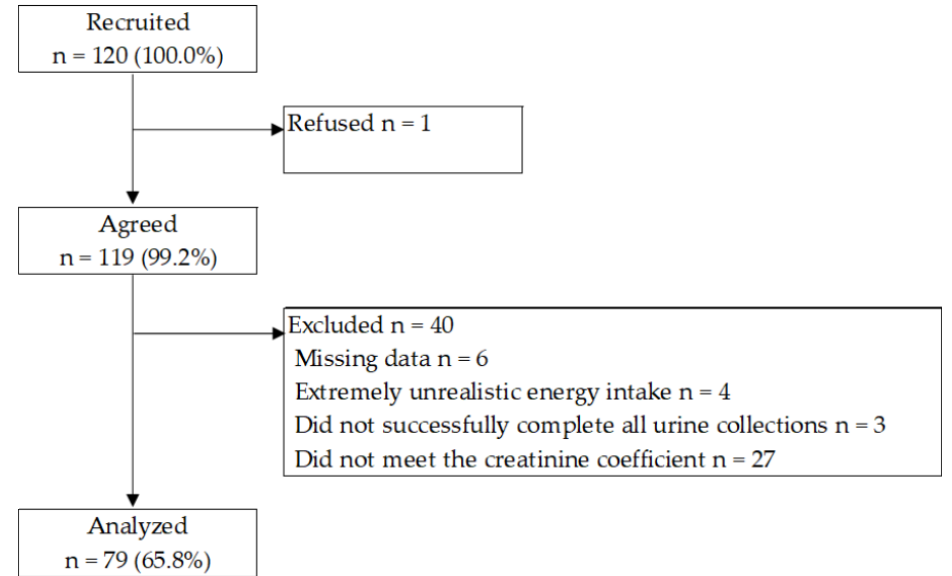
Figure 1. Flowchart of the study participants. Table 1. Basic characteristics of the study participants (mean values and standard deviations or number and percentages).